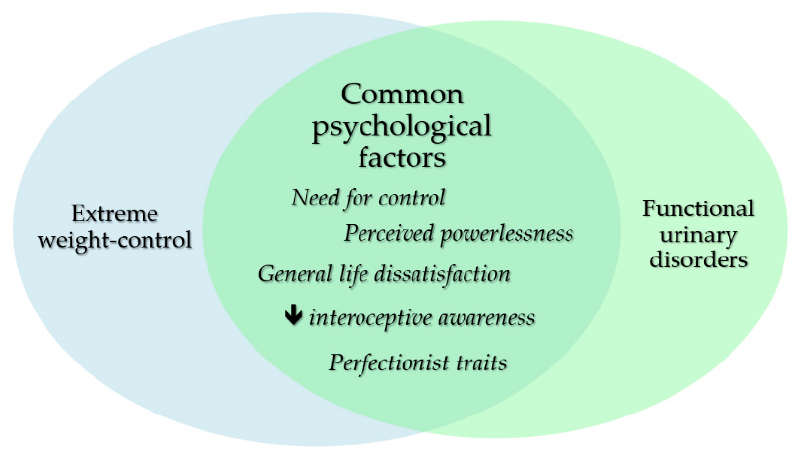
Figure 1. Psychological factors implicated in functional urinary disorders among females with ED.